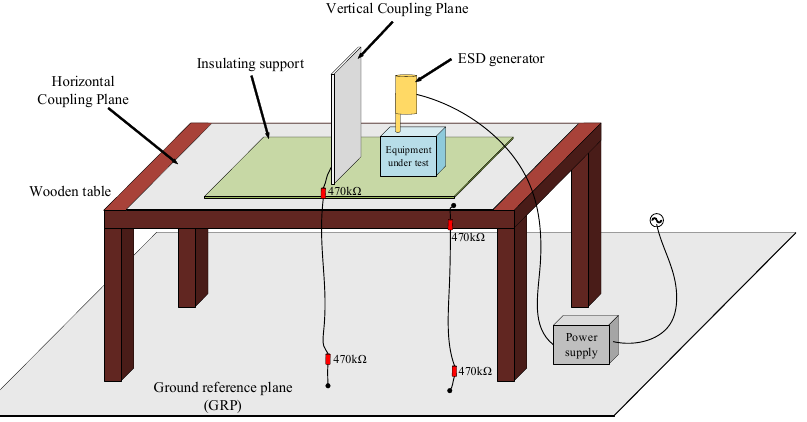
Figure 2. ESD testing configuration according to IEC 61000-4-2.